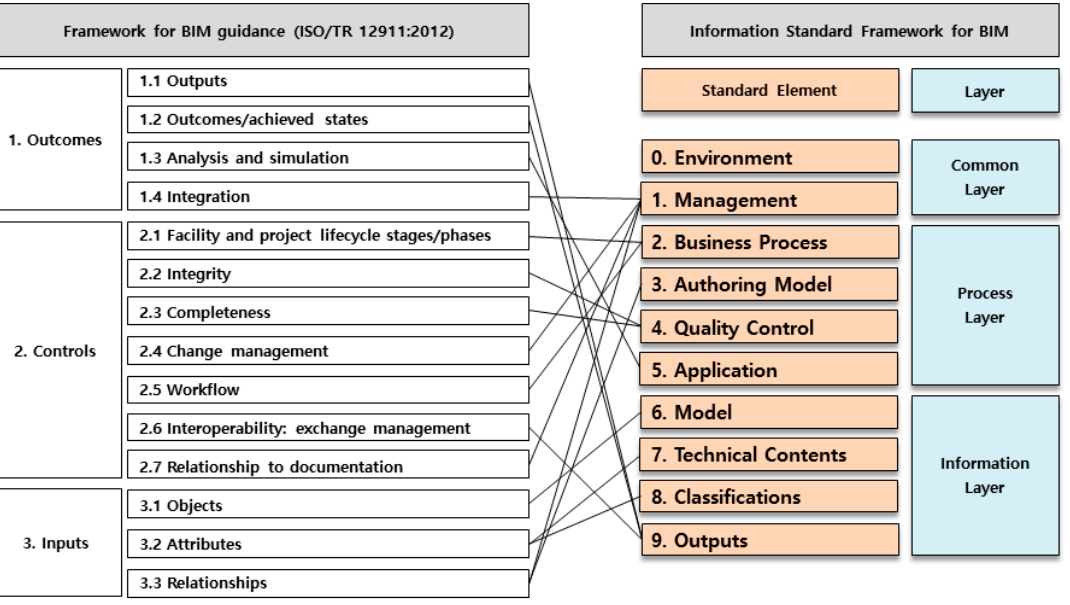
Figure 3. Conformance with ISO 12911.